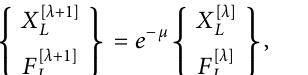
P cells with a free end (N) and a fixed end